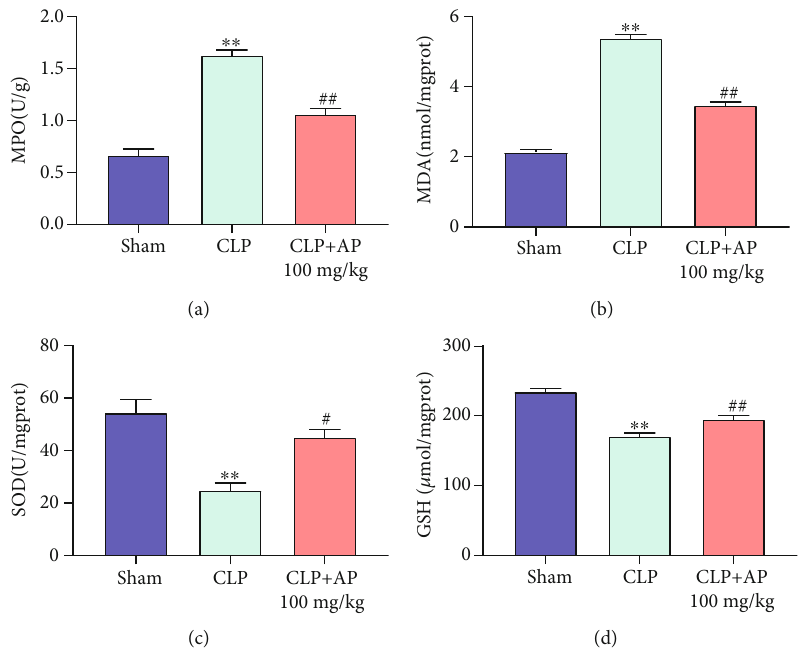
Figure 4: AP alleviated the oxidative stress in sepsis-induced ALI mice. The activity of MPO, MDA, SOD, and GSH was detected using the corresponding test kit. ∗∗ P < 0 : 01 , vs. Sham group; ## P < 0 : 01 , vs. CLP group.